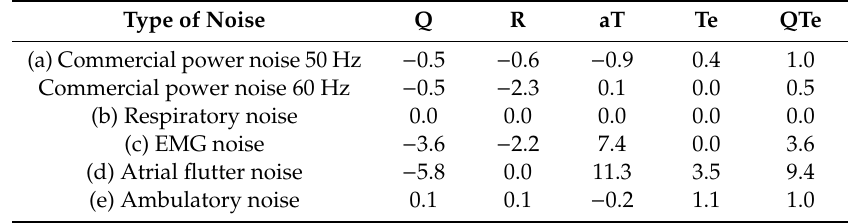
Figure 3. Noise tolerance simulation.On a normal ECG, ( a ) commercial power noise (50 Hz), ( b ) ambulatory noise, ( c ) respiratory noise, ( d ) atrial flutter noise, and ( e ) EMG noise were synthesized to test our ECG recognition technique. In this figure, the vertical lines beside the letters Q, R, aT, and Te indicate recognition points. Table 1. Differences in recognition points between normal ECG and ECG containing various types of noise.